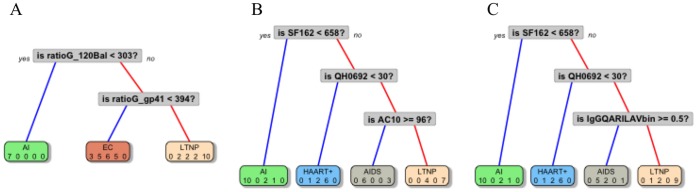
Classification trees resulting from CART analysis, performed with binding antibodies (A), functional activities data data (B) or antibody mediated binding and functional activities (C).Numbers inside grey squares indicate the discrimination level and are expressed as dilution 1/n.